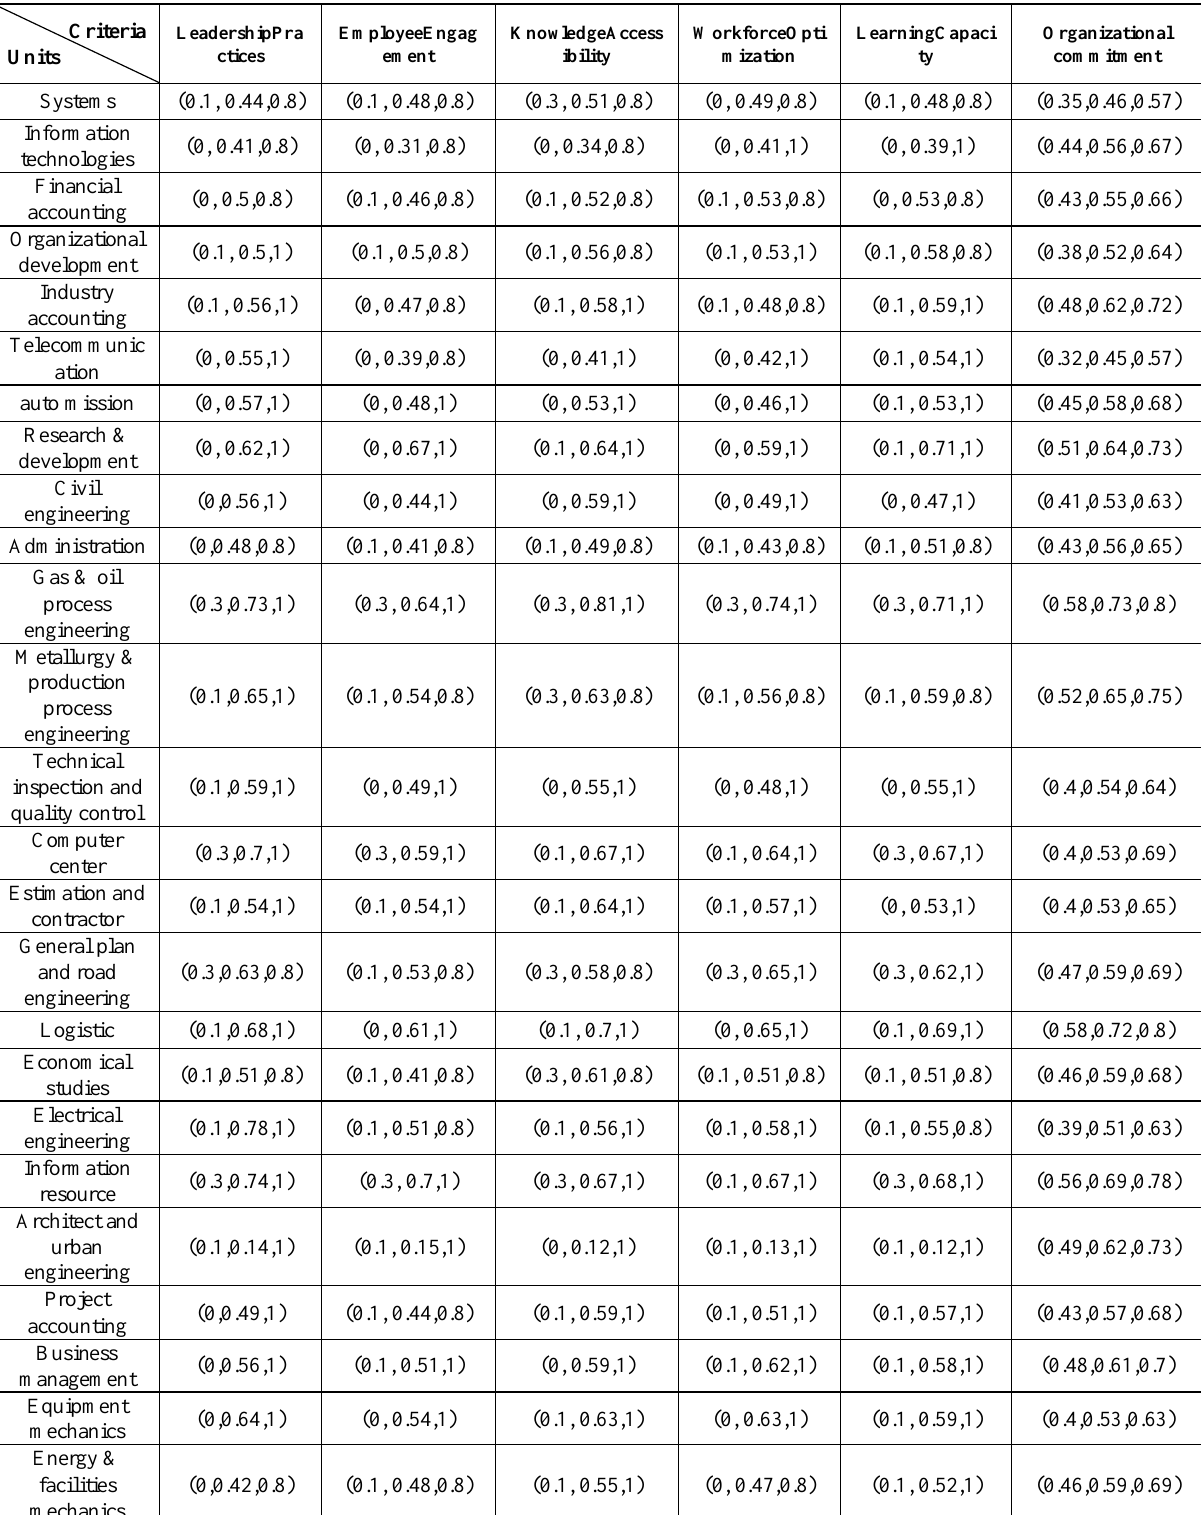
Table2. Number of inputs and